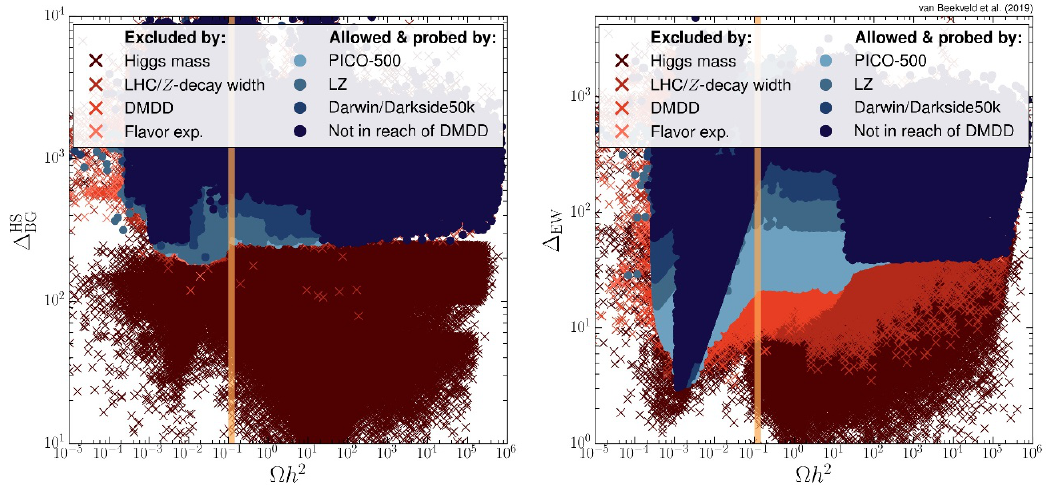
Figure 4 . Generated spectra for the mSUGRA-var model. The left (cid:12)gure shows (cid:1) HS of (cid:10) h 2 , the right (cid:12)gure shows (cid:1) EW as a function of (cid:10) h 2 . The color code and plotting order is the same as in (cid:12)gure 1. The orange band indicates (cid:10) h 2 = 0 :